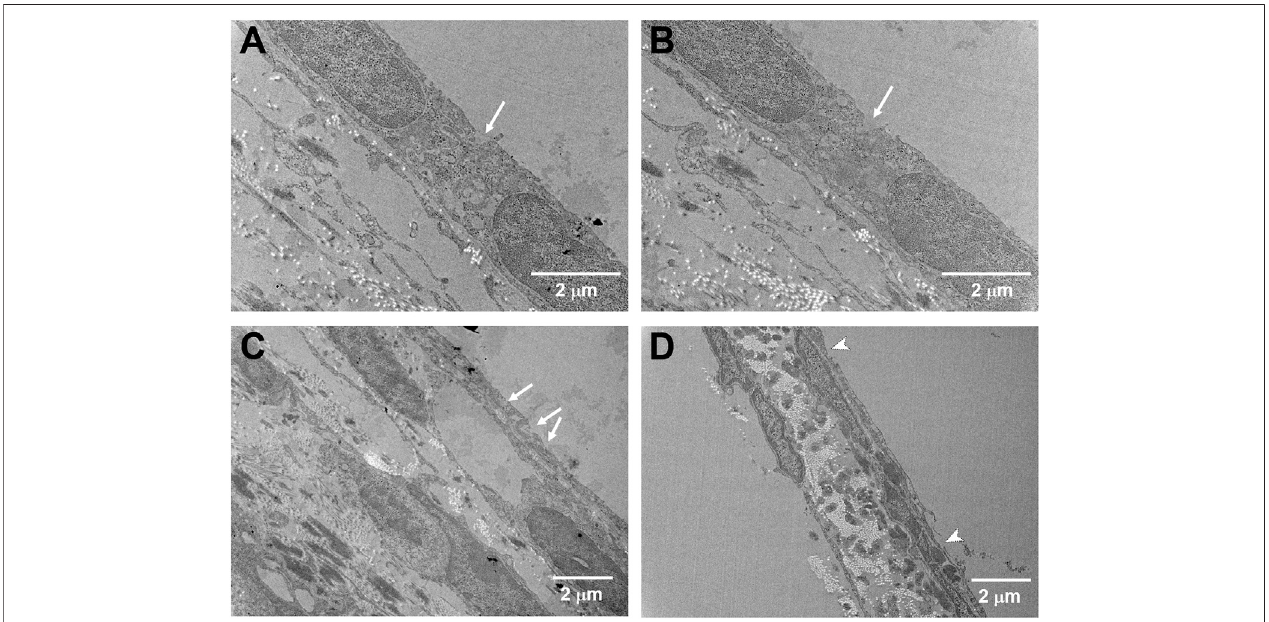
FIGURE 6 | Cross-sectional TEM images of the USMB-treated RWM under different magni fi cations. Samples were taken immediately from the mice after three USMB treatments. (A − C) Pore-like openings with various depths and sizes (arrows) were distributed along the outer epithelium of the RWM. (D) Some areas of the membrane exhibited sunburn-like peeling over the outer epithelium